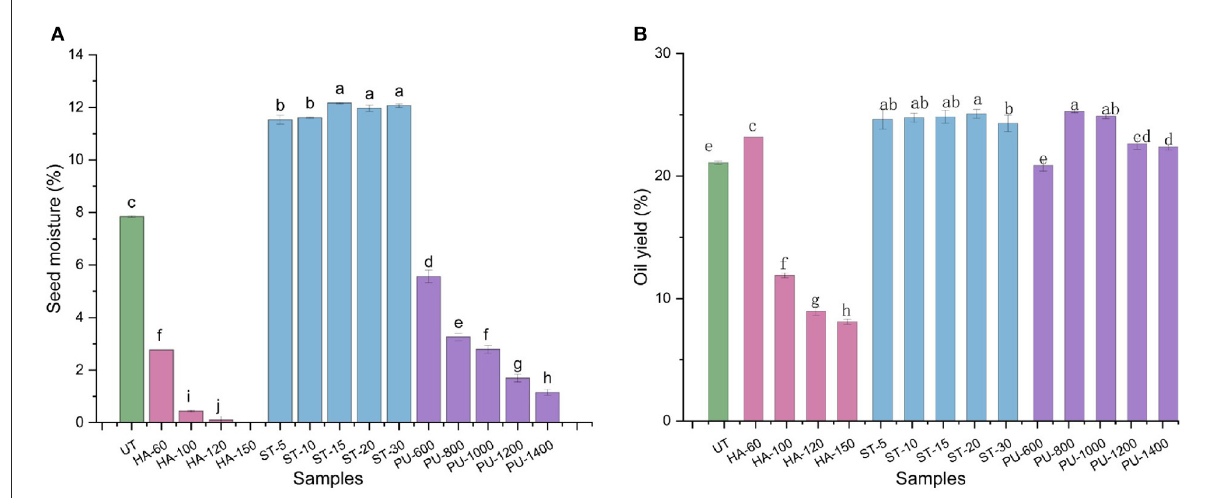
FIGURE2 The moisture content (A) and oil yield (B) of camellia seeds treated with different pretreatment methods (UT, untreated; HA, hot air; PU, puffing; ST, steam). Bars with no letter in common are significant different ( P < 0.05). The numbers following the abbreviations represent the processing conditions for each pretreatment